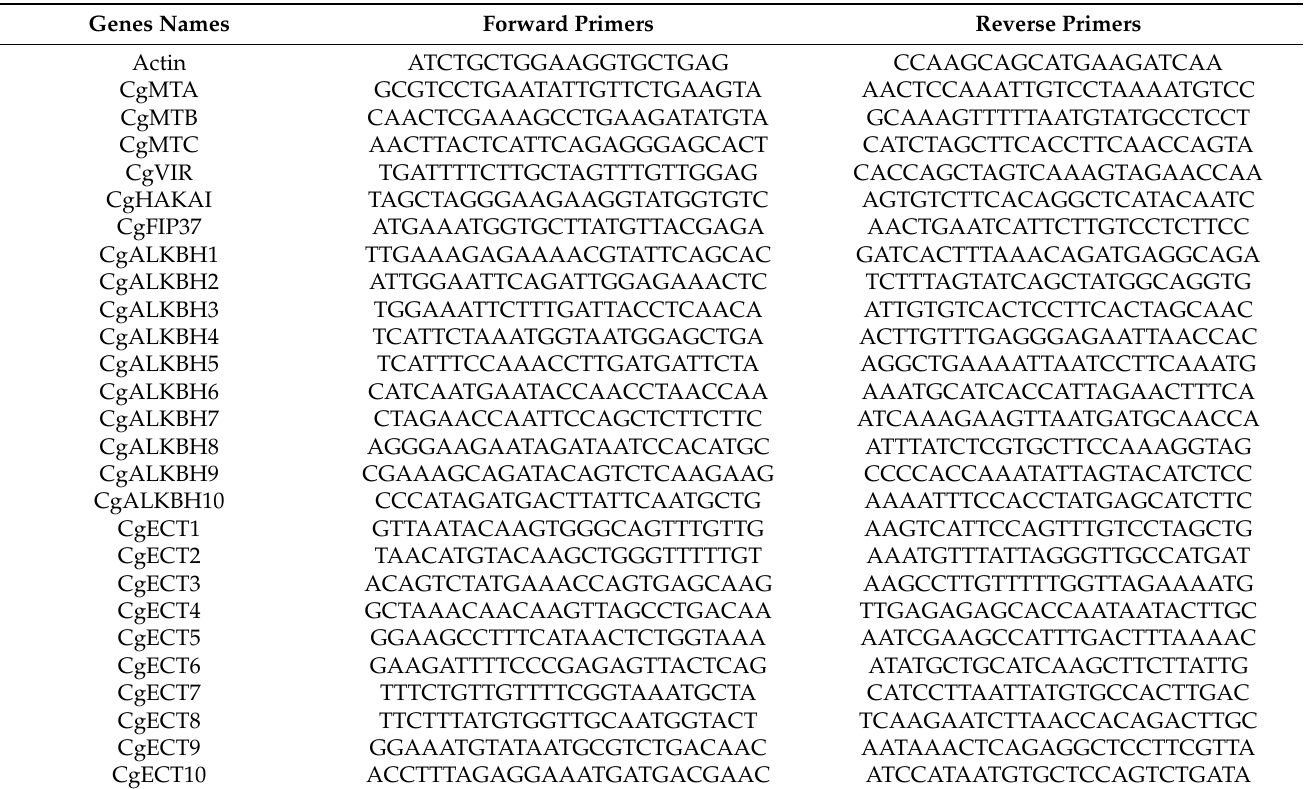
Table 1. The primers used for